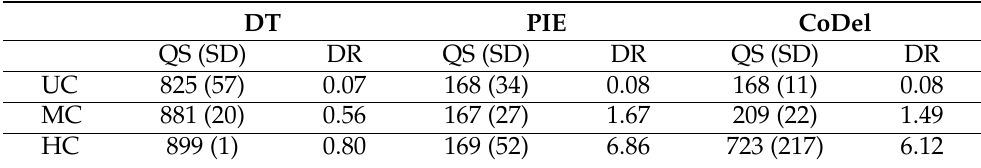
Table 11. Mean queue length (QS) and standard deviation (SD) of queue length [pkts] and packet congested, HC—heavily congested